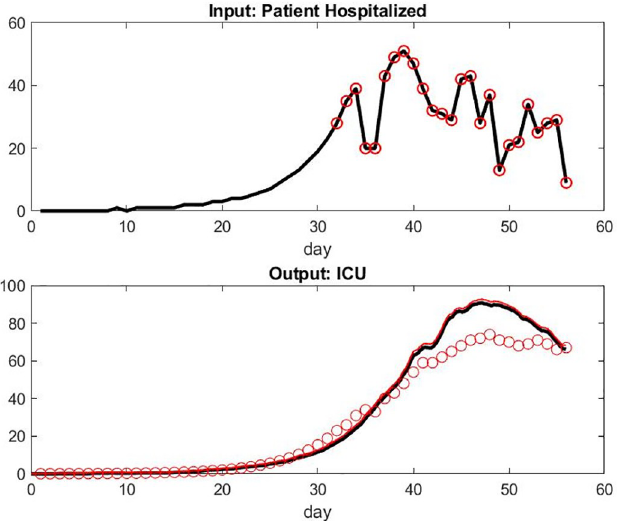
Fig 6. Top: Input of Patient Hospital Admission in Alsace, France. Bottom: Model of Patient Under Mechanical Ventilatin in ICU Versus Data Set.